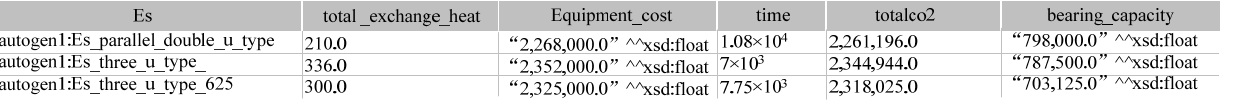
Figure 13. Execution and results of querying R.3 in Table 4.